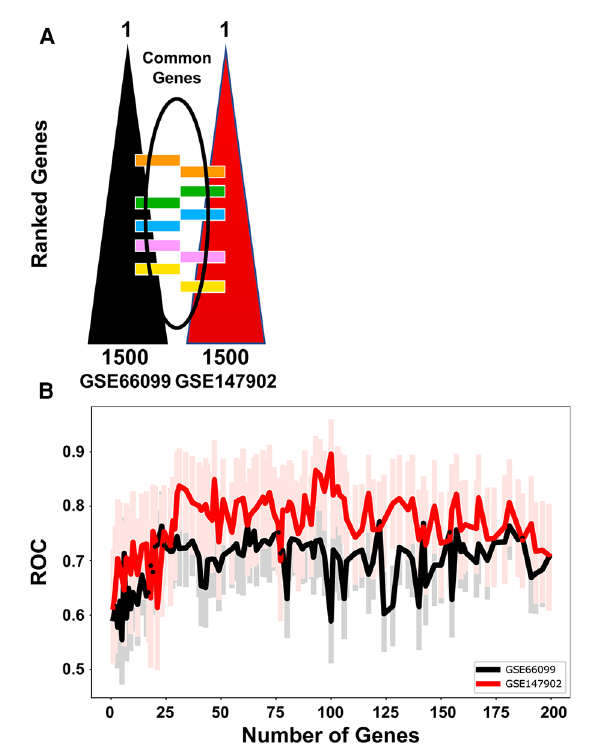
FIGURE 2 The receiver operative curve (ROC) characteristics for different number of genes (12, 21, 48, 69, 92, 185) selected to model moderate/severe pediatric acute respiratory distress syndrome (ARDS; P a O 2 /F i O 2 <200) vs. mild pediatric ARDS (P a O 2 /F i O 2 =200 – 300). ( A ) The top 1,500 genes were ordered in a rank-list from GSE66099 and GSE147902. The lists were compared and common genes were added sequentially in the model in groups of 10 genes per iteration. ( B ) The ROC characteristics were calculated for each addition of ten genes in the model up to 185 genes total. The lines show the ROC value for GSE66099 (black) and GSE147902 (red), respectively. The faint red and black lines are the 95% con fi dence intervals for the ROC for each iteration of the model. The ROC plateaus between 25 and 30 genes for each